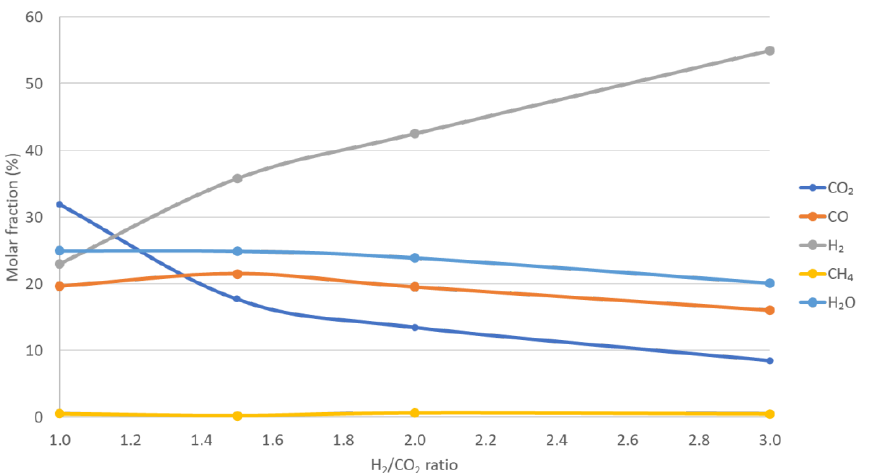
Figure 4. RWGS outlet gas composition as a function of the H 2 /CO 2 ratio after the removal of water. − 1 ; pressure: 6 bar; temperature: 850 ◦ C. GHSV: 35,800 h −1 ; pressure: 6 bar; temperature: 850 °C. GHSV: 35,800 h